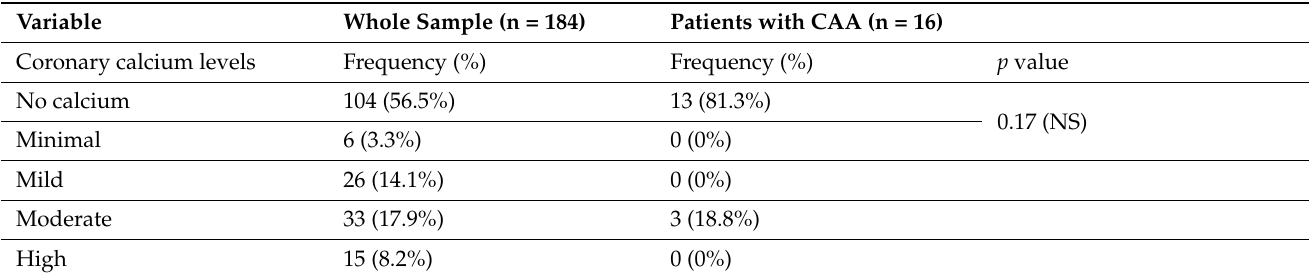
Table 1. The association between CAA and coronary calcium